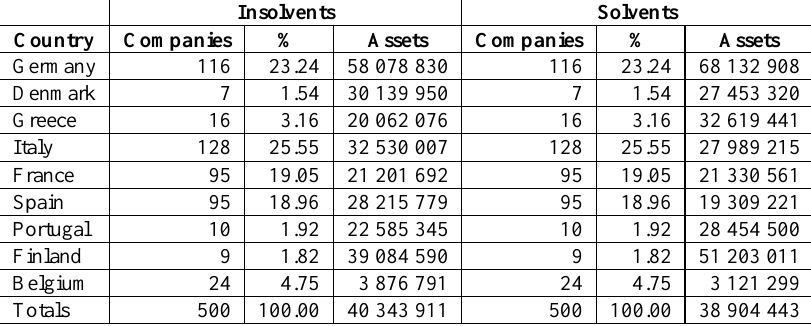
Table 5. Sample structure of the industrial companies used to estimate.